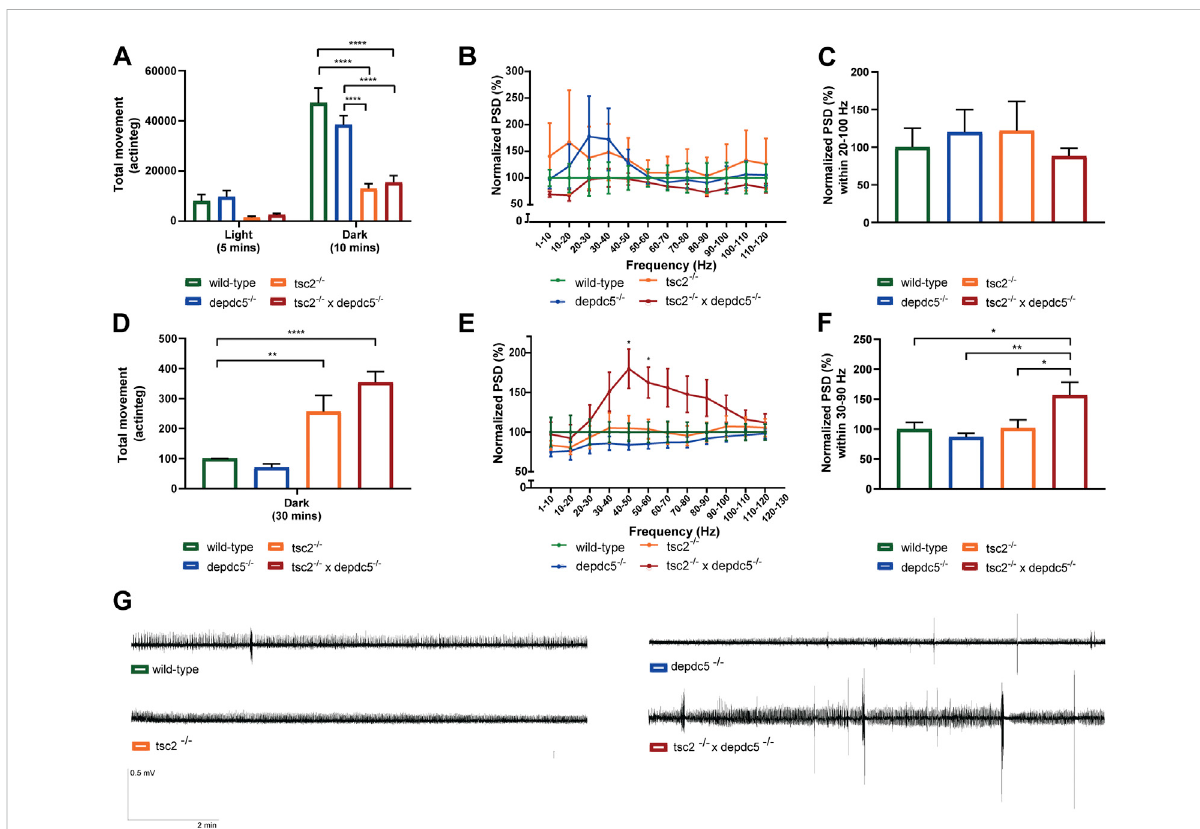
FIGURE 3 Locomotor behaviour and electrophysiology assessment of double homozygous zebra fi sh larvae. (A) Locomotor activity (average total movement, expressed in actinteg units) tracked during light (5 min) and dark (10 min) periods of wild-type, depdc5 − / − , tsc2 − / − , and double homozygous larvae at 5 dpf. Data are presented as mean ± SEM, n = 13 – 29 larvae/condition. Signi fi cant values (two-way ANOVA) are noted as **** p < 0.0001. (B,C) Powerspectraldensity(PSD)rangingfrom0to120 Hznormalizedagainstthewild-typegroup.ThePSDper10 Hz (B) and per larvae (C) over the 20 – 100 Hz region are plotted as mean ± SEM, n = 6 – 23 larvae/condition. No signi fi cant values (one-way ANOVA) were detected, ns p > 0.05. (D) Locomotor activity tracked in the dark (30 min) in the presence of 5 mM PTZ of wild-type, depdc5 − / − , tsc2 − / − , and double homozygouslarvaeat5dpf.Dataarepresentedasmean±SEM, n =8 – 16larvae/condition.Signi fi cantvalues(two-wayANOVA)arenotedas**** p < 0.0001,** p < 0.01. (E,F) Powerspectraldensity(PSD)rangingfrom0to120 Hznormalizedagainstthewild-typegroup.Allanimalsweretreatedwith 5 mM PTZ. The PSD per 10 Hz region (E) and per larvae over the 30 – 90 Hz region (F) are plotted as mean ± SEM, n = 17 – 26 larvae)/condition. Signi fi cantvalues(one-wayANOVA)arenotedas** p < 0.01and* p < 0.05. (G) Representative10-minsrecordings(scalebar;0.5mV – 2 min)ofwild- type, depdc5 − / − , tsc2 − / − , and double homozygous larvae at 5 dpf after 5 mM PTZ immersion for 15